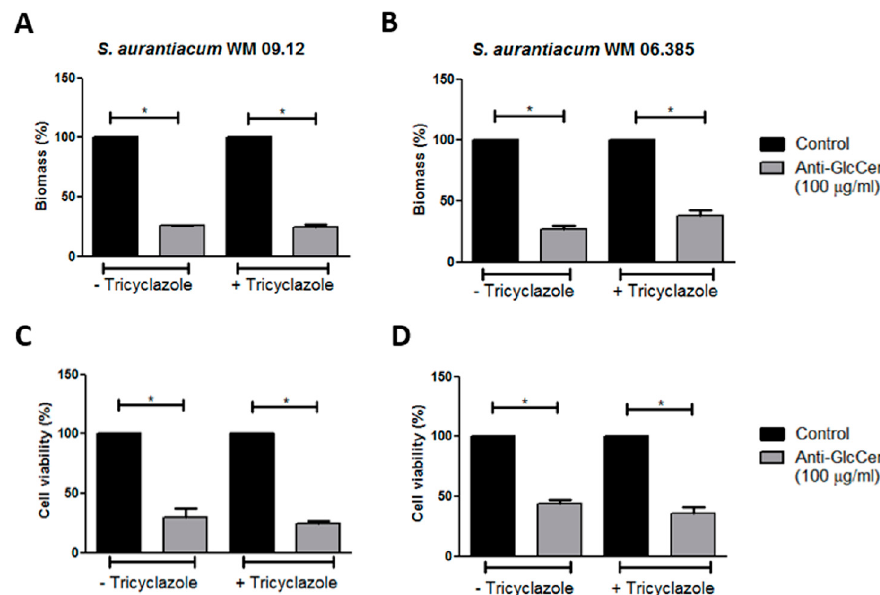
Figure 6. Influence of anti-GlcCer in S. aurantiacum WM 09.12 ( A , C ) and WM 06.385 ( B , D ) biofilm formation. S. aurantiacum biofilms formed in the presence of anti-GlcCer (100 µg/mL) for 24 h had total biomass analyzed by crystal violet staining ( A , B ) and cell viability determined by XTT-reduction assay ( C , D ). Conidia were cultivated in the absence ( − ) or presence (+) of tricyclazole (16 µg/mL). * p < 0.01.